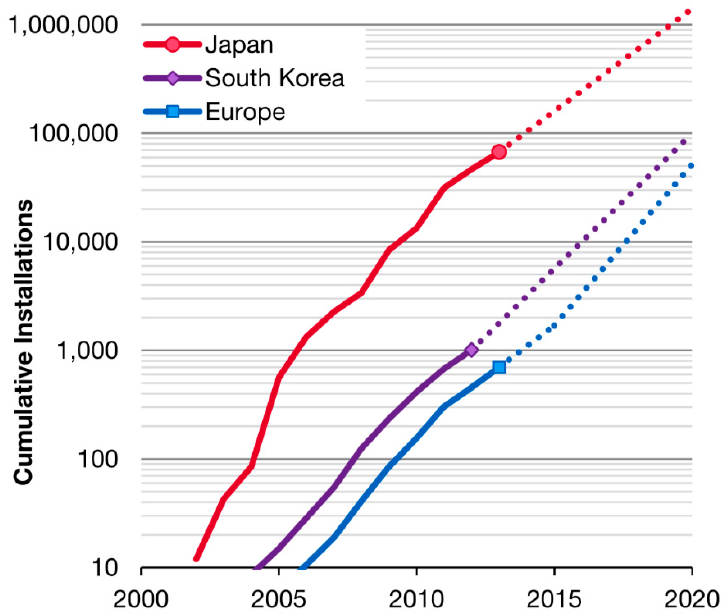
Figure 2. The number of residential fuel cell micro combined heat and power systems [91]. Table 2. Commercially available fuel cell combined heat and power [90].